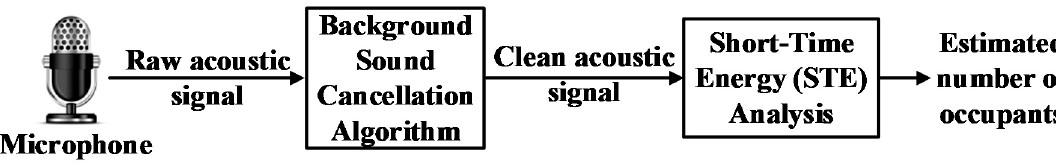
Figure 1. Overview of audio-processing algorithms with background sound-cancellation algorithm.